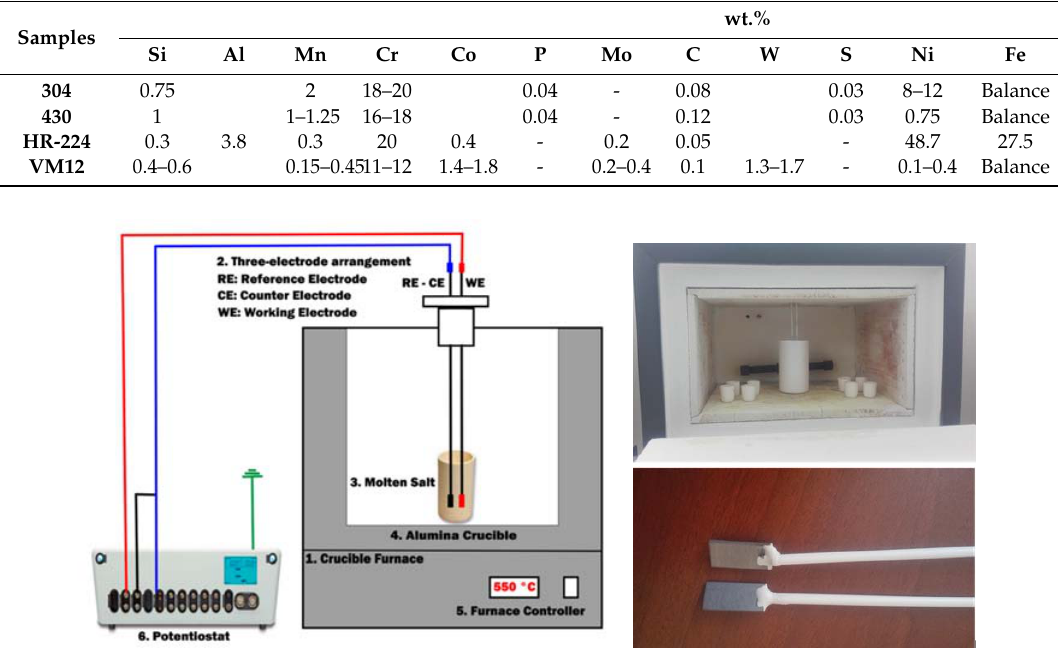
Figure 6. Schematic of the electrochemical system. 1: Crucible furnace; 2: three-electrode arrangement (Re: reference electrode, CE: counter electrode, WE: working electrode or sample); 3: molten salt; 4: alumina crucible; 5: furnace controller; 6: potensiostat ( left ); predisposition of the high temperature furnace and welded and cemented electrodes in alumina tubes ( right ).